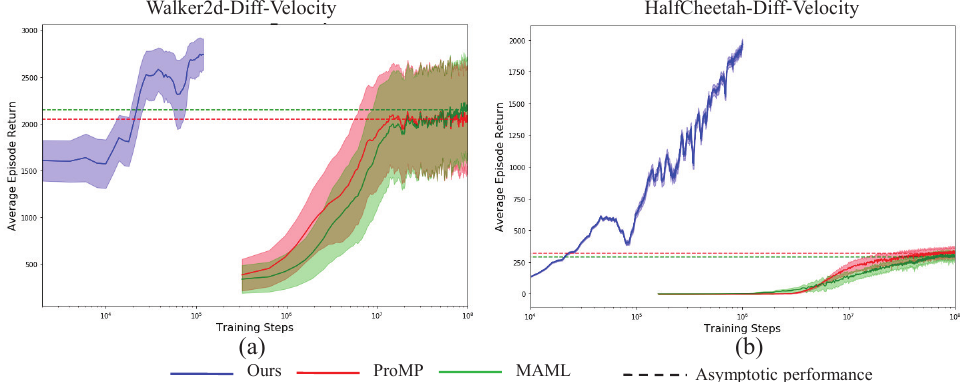
Figure 3. Performance comparisons for Walker2d ( a ) and Half-Cheetah ( b ) with different forward velocity transfer learning tasks.